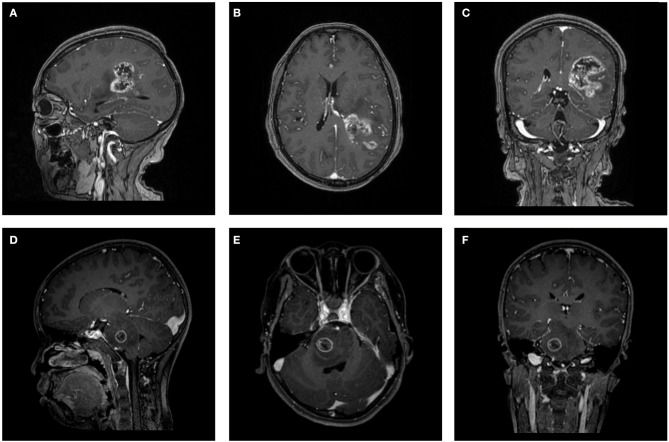
Two examples of contrast-enhanced MRI images. (A–C) Patient with GBM in (A) parasagittal, (B) axial, and (C) coronal view. (D–F) Patient with AO in (D) parasagittal, (E) axial, and (F) coronal view. GBM, glioblastoma; AO, anaplastic oligodendroglioma.